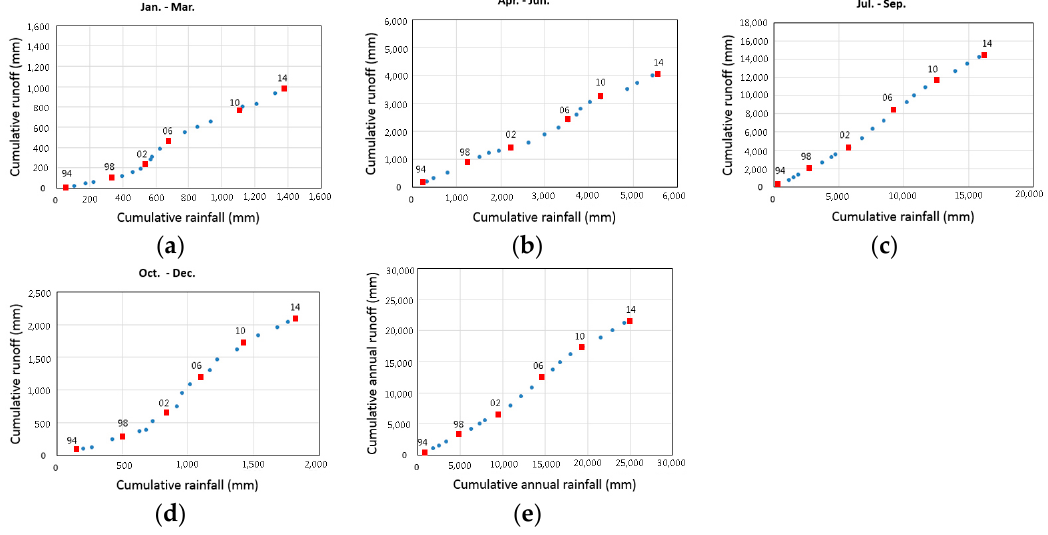
Figure 6. Detection of change point in Seom River basin (double mass curve). ( a ) JFM; ( b ) AMJ; ( c )